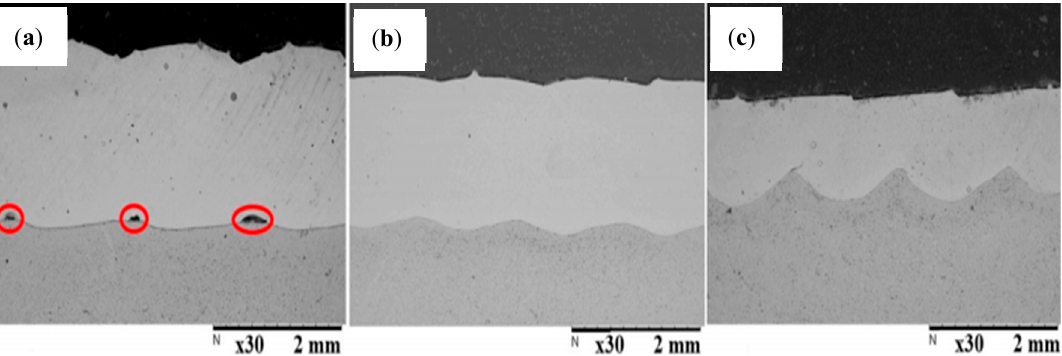
Figure 4. Cross-section morphology of Ni-Cr-B-Si coating: ( a ) 210.0 J/cm cross-section morphology, ( b ) 64.6 J/cm cross-section morphology, and ( c ) 58.3 J/cm cross-section morphology.